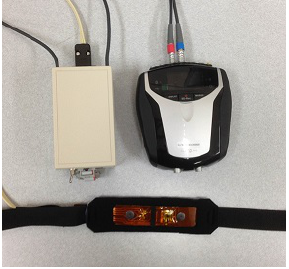
Fig. 5. Measurement device NeXus10.